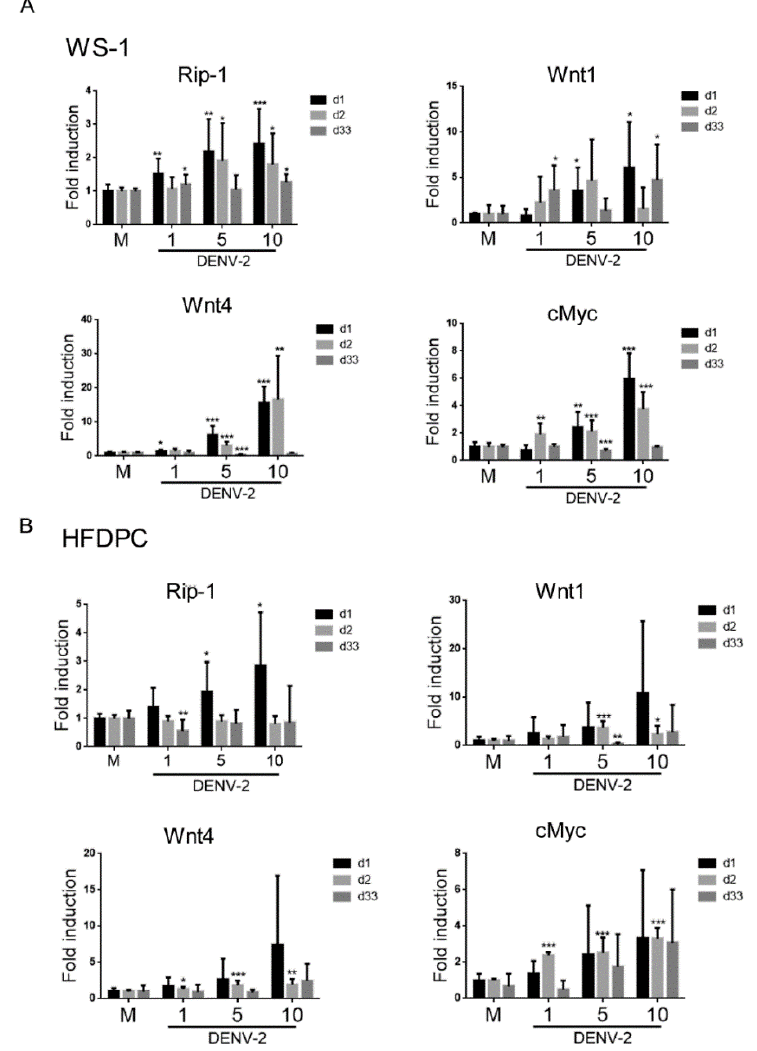
Figure 7. The expression of hair growth cycle genes in cells with DENV-2 infection for indicated days. ( A , B ) qRT-PCR of Rip-1, Wnt1, Wnt4 and cMyc was conducted in WS1 and HFDPCs with DENV-2 (MOI 1, 5, and 10) for 1, 2, and 33 days. The mRNA expression level was normalized to Gapdh , and the fold induction to the mock control. Data are presented as mean ± SD from three independent tests. * p < 0.05, ** p < 0.01, *** p < 0.005 vs. mock control.